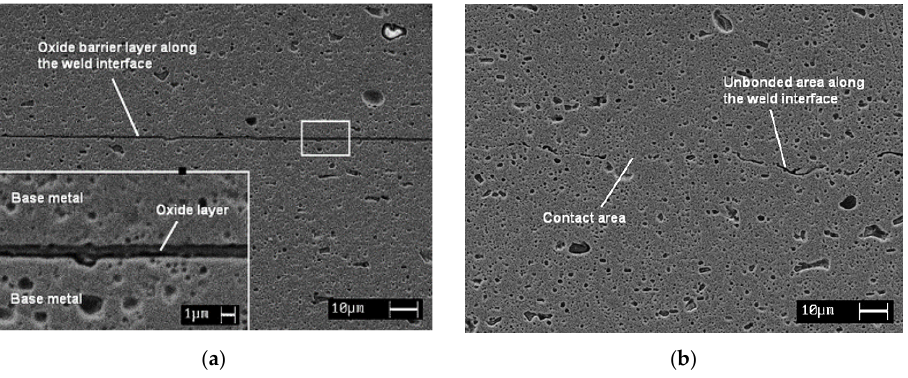
Figure 6. Micrographs of Al6061 foils ( a ) unprepared and ( b ) surface prepared welded using UC [47].